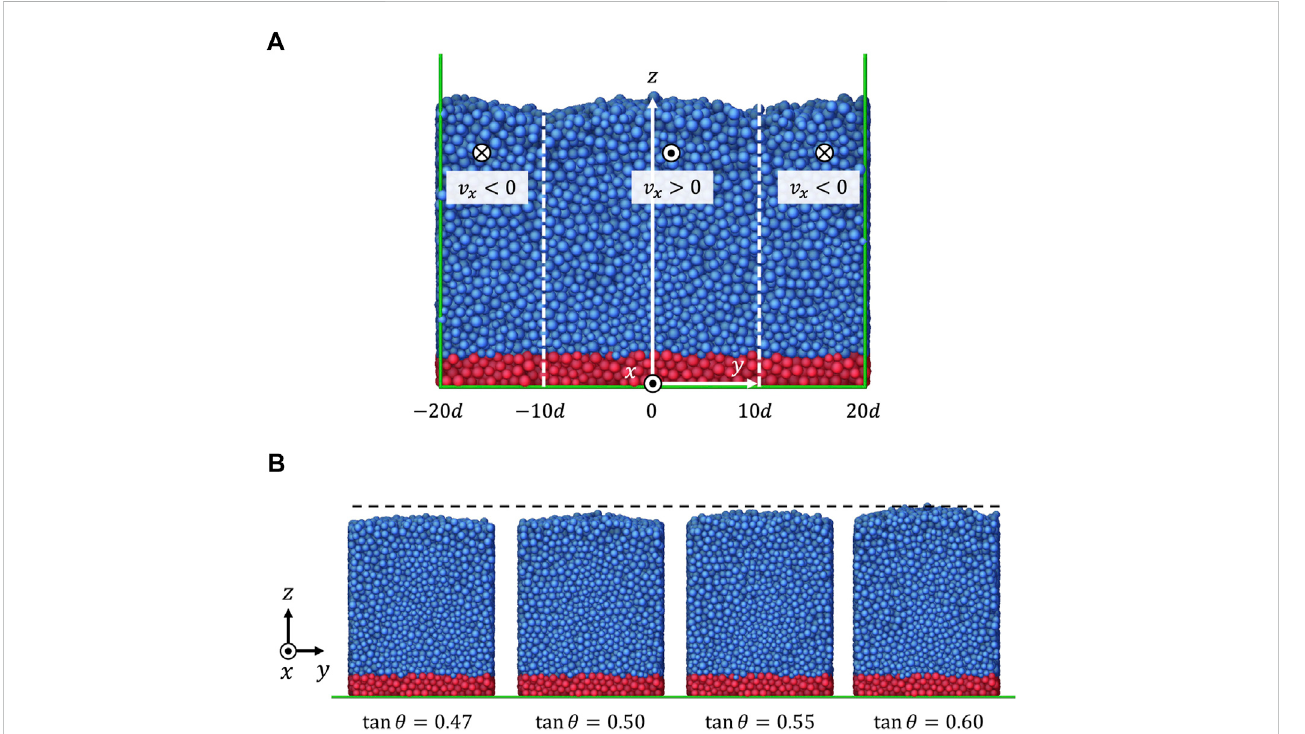
FIGURE 10 (A) DEM simulation of inclined chute fl ow with θ = tan − 1 (0.60). Green lines are boundaries of the DEM simulation domain which is periodic in x and y directions. v x is positive in the middle zone ( − 10 d < y < 10 d ) where gravity is (cid:2) G (cid:1) G sin θ ^ x + G cos θ ^ z and negative in the rest where gravity is (cid:2) G (cid:1) − G sin θ ^ x + G cos θ ^ z . Red particles are fi xed. (B) Inclined chute fl ows with different inclination angles viewed from the positive x -axis. Only particles in − 10 d < y < 10 d are shown. Dashed line indicates the maximum height of the surface for tan θ = 0.60. From the gaps between the dashed line and the surfaces, we can see that the volume of the material increases as the inclination angle increases and the material fl ows faster. The surface becomes convex due to normal stress